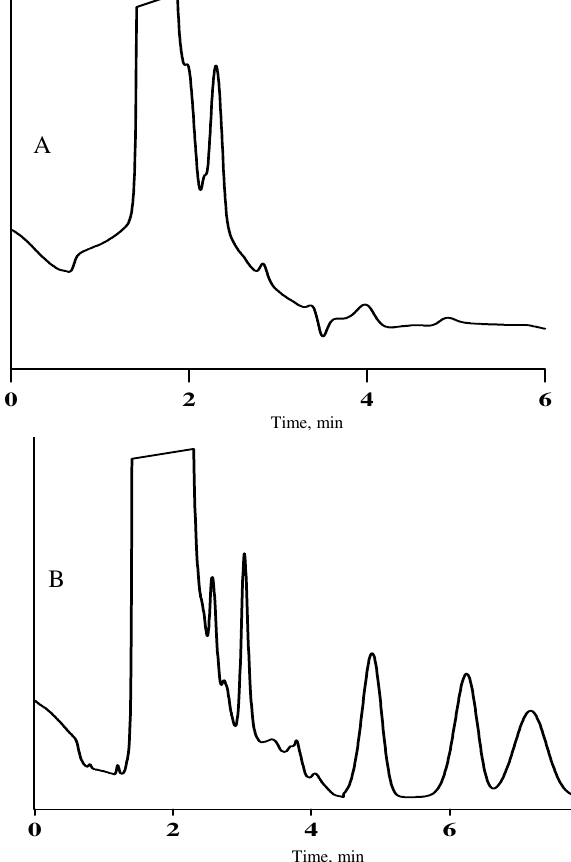
Figure 3. (A) Chromatogram of blank serum sample eluted in optimum mobile phase (B) Chromatogram of spiked serum sample containing three benzodiazepines in optimum mobile